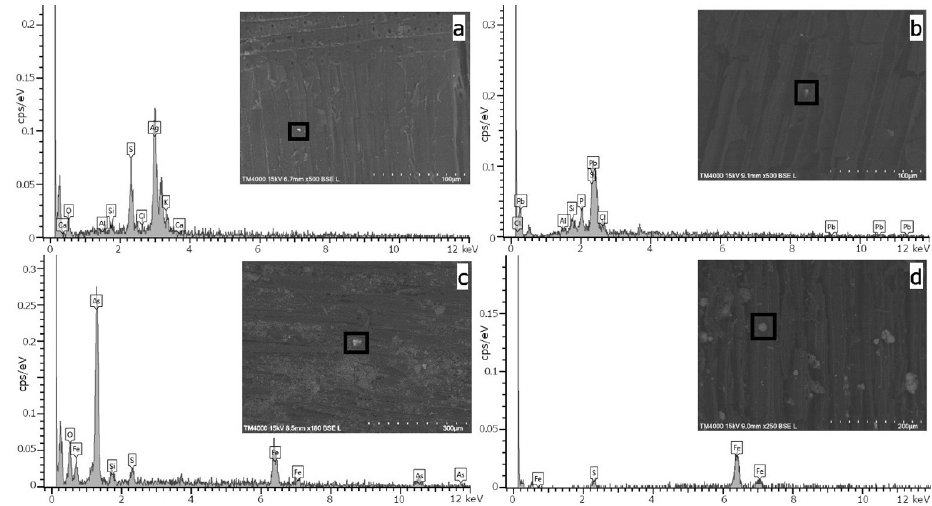
Figure 6. SEM images and EDS spectra for selected archaeological samples: S2 ( a ), P1 ( b , c ) and P3 ( d ). Table 3. Main crystalline phases identified via Xray diffraction.